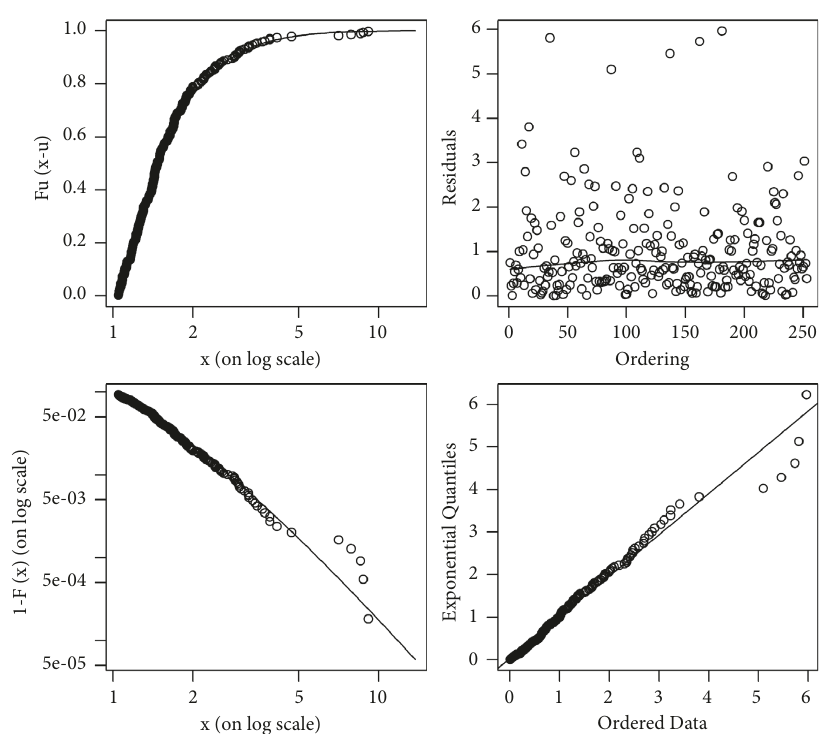
Figure 6: Rapeseed oil positive returns GPD fitted diagnostic